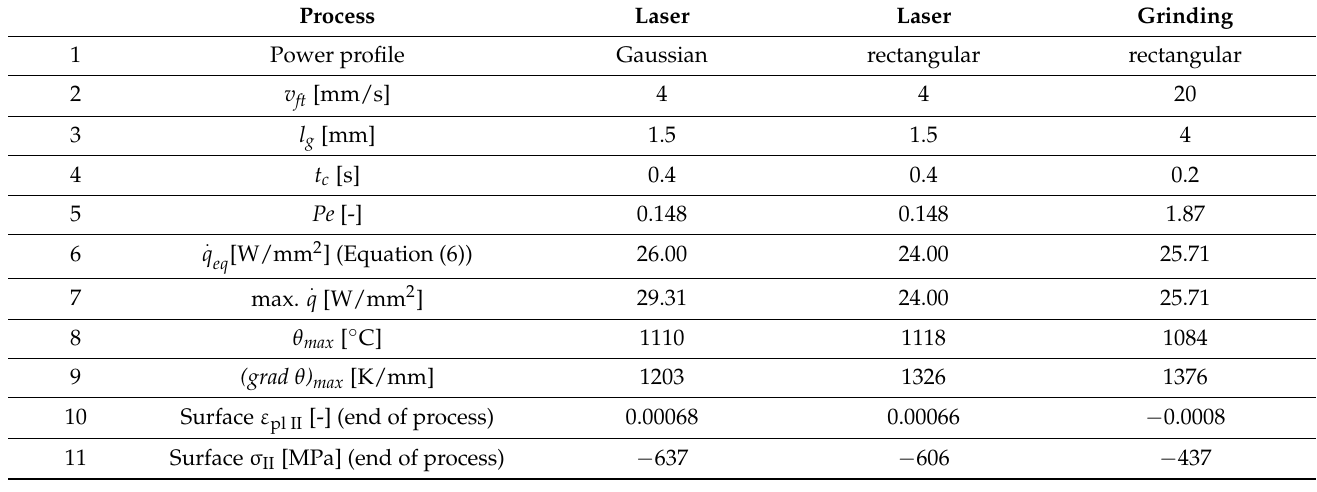
Table 3. Comparison of different power profiles and Peclet numbers.